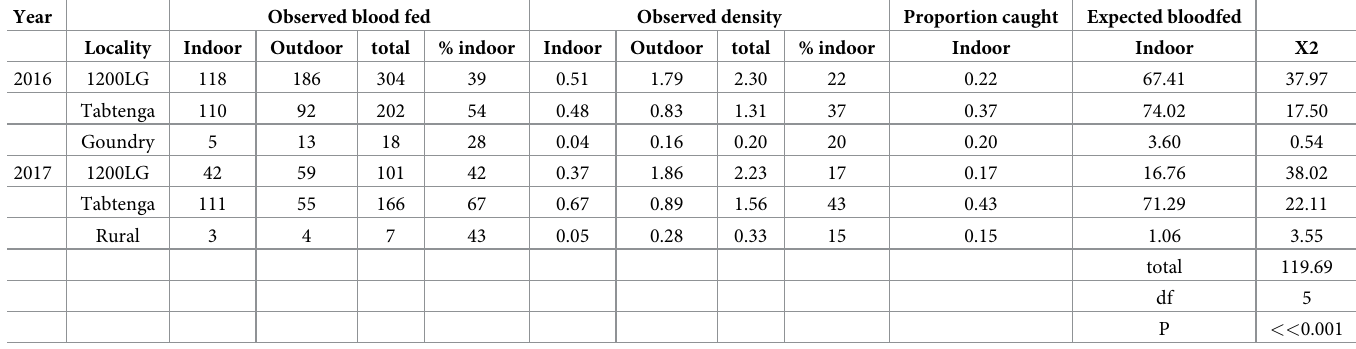
Table 2. Numbers of bloodfed Aedes aegypti and density/house in indoor and outdoor resting collections in domestic housing in Ouagadougou. The expected num- ber of bloodfed mosquitoes indoors was calculated from the proportion caught indoors and compared to observed numbers bloodfed using a chi-square goodness of fit